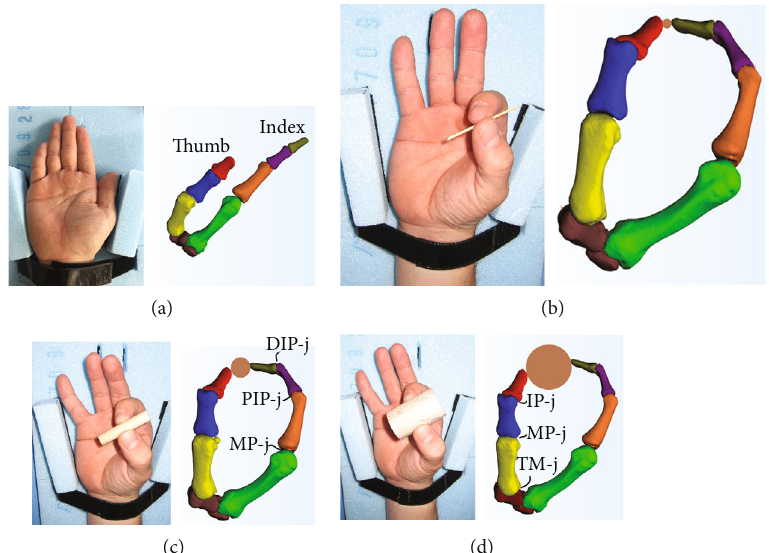
Figure 1: Postures during CT (computed tomography) scanning and in the three-dimensional bone models. (a) basic posture, (b) pinching a 2mm diameter cylinder, (c) pinching a 10mm diameter cylinder, and (d) pinching a 30 mm diameter cylinder.